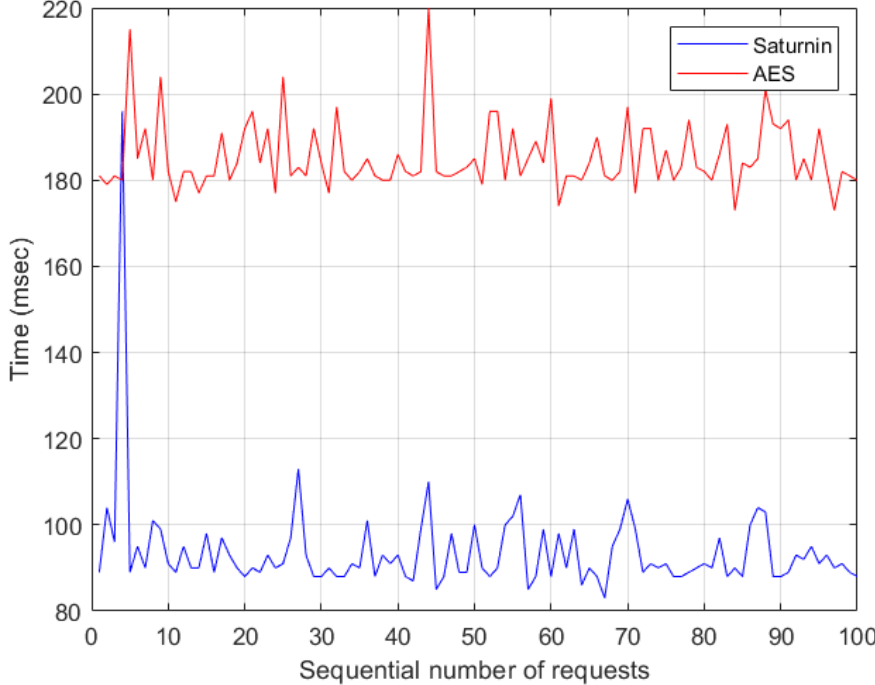
Figure 4. RTTs for 100 transactions, initiated by client’s requests, for 32-byte